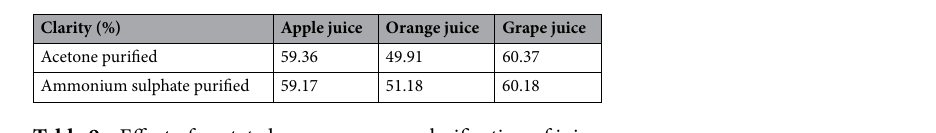
Table 9. Effect of pectate lyase enzyme on clarification of juices.